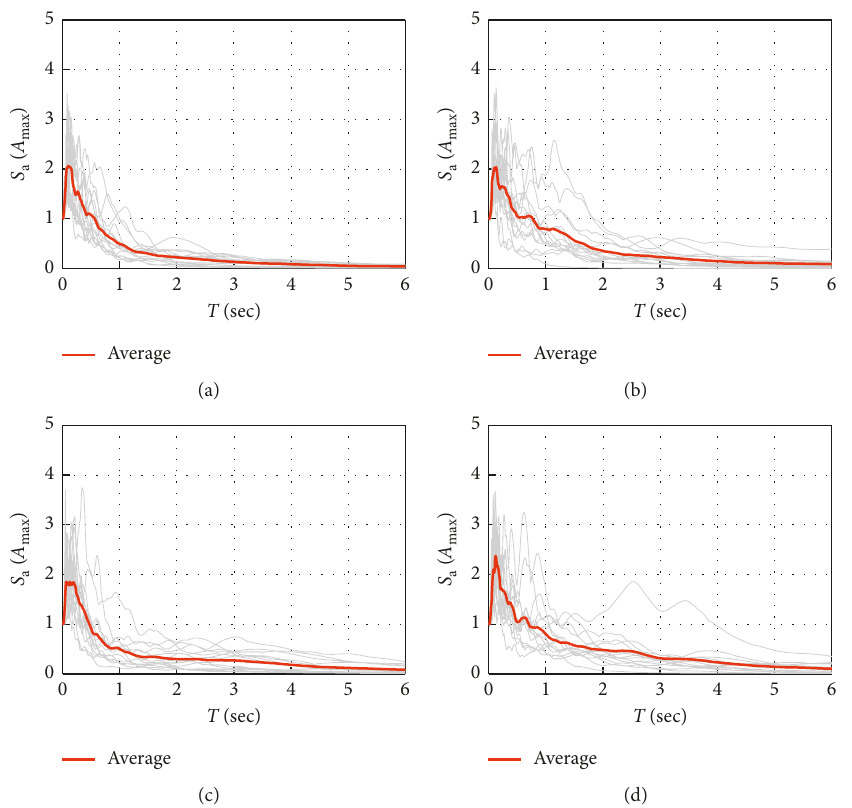
Figure 8: Acceleration response spectra of the vertical component. (a) Site I. (b) Site II. (c) Site III. (d) Site IV.